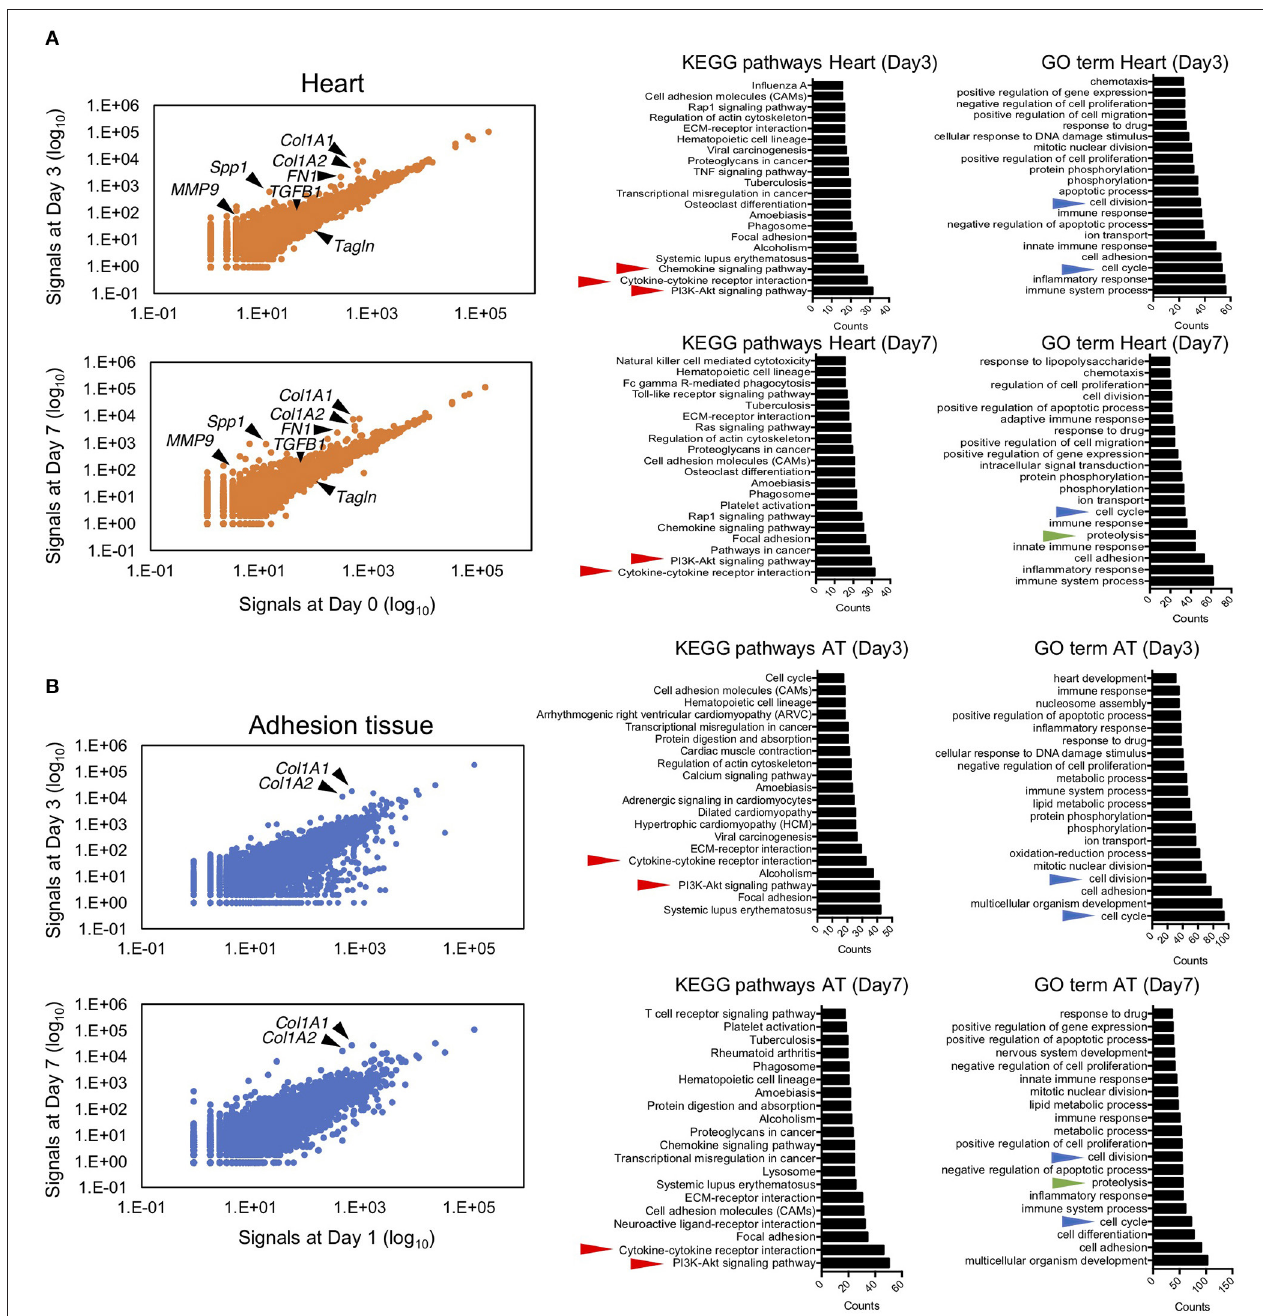
FIGURE 4 | Next-generation sequencing of RNA from myocardial and adhesion tissues. (A) Scatter plot illustrating relative expression values obtained using RNA sequencing of myocardial tissues on days 3 and 7 after talc injection (left). The middle and right panels show the top 20 enriched gene ontologies based on KEGG and GO term database pathways, respectively. Red, blue, and green arrowheads indicate inflammation-, cell growth-, and proteolysis-related ontologies, respectively. (B) Scatter plot of relative expression values obtained by RNA sequencing of adhesion tissues on days 3 and 7 after induction (left). The middle and right panels show the top 20 enriched gene ontologies based on KEGG and GO term database pathways, respectively. Red, blue, and green arrowheads indicate inflammation-, cell growth-, and proteolysis-related ontologies,